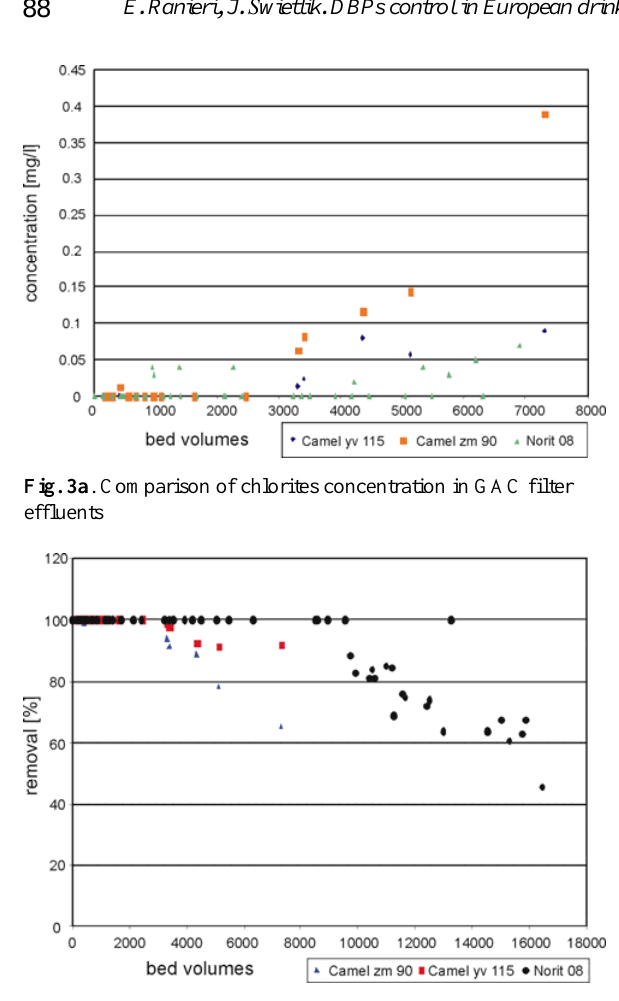
Fig . 3b. Percentage of chlorites removal after GAC filtration in Mosina and Fortore